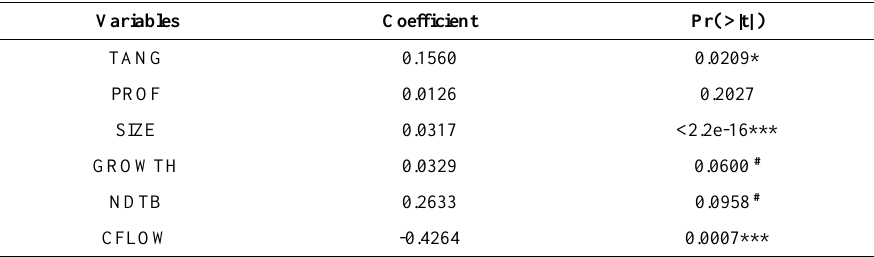
Table 7. Estimates of the panel data model with random effects for individuals – Best model.